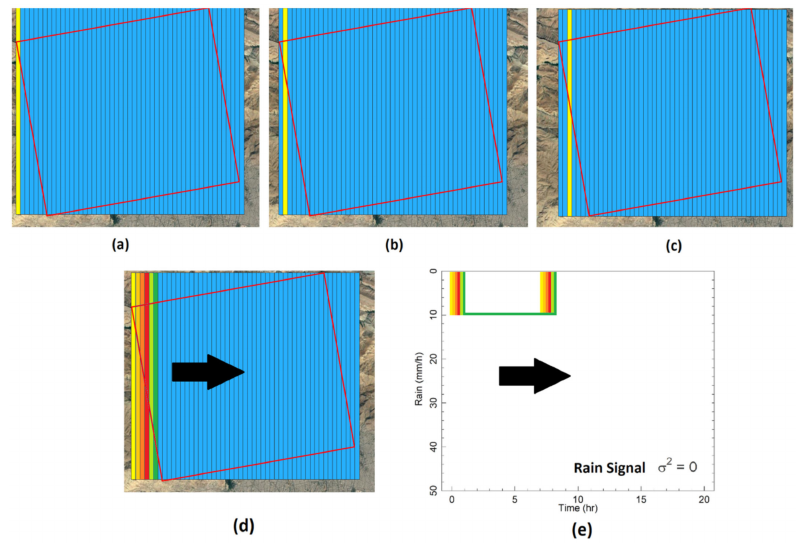
Figure 5. Discretization of the upper subdomain (red line) into cells (blue rectangles) with dw = 0.5 km to model rainfall movement in the simulations. As an example, the movement of rain signal σ 2 = 0 with a velocity of v = 5 km/h from west to east for some cells is illustrated ( a – c ). The hyetographs of the few first cells (illustrated in e ) from the west ( d ). The colors in ( d ) and ( e ) indicate the